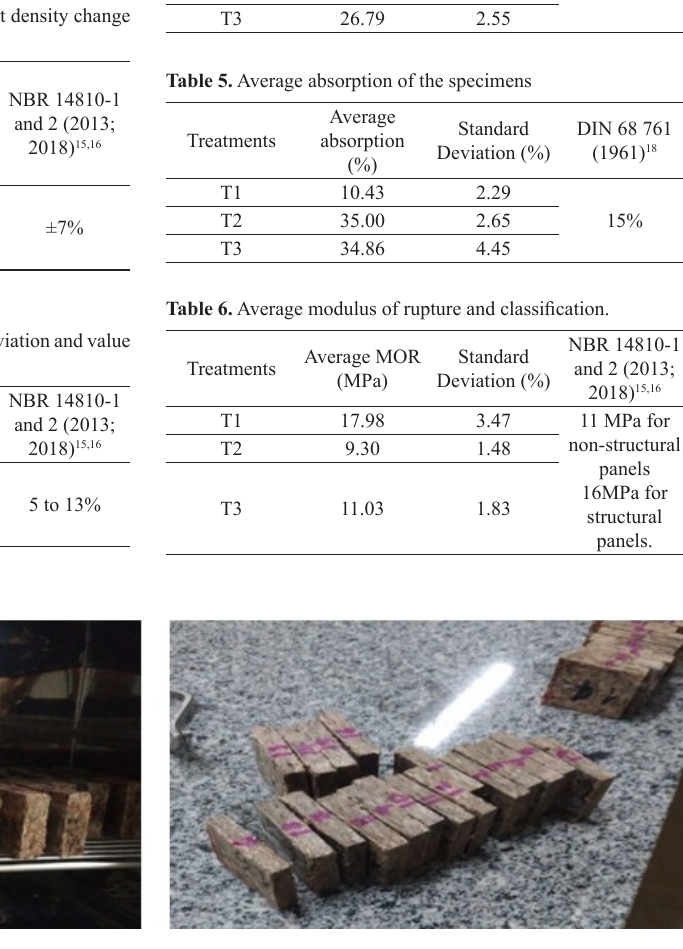
Figure 6. Aspects of specimens (a) Specimes at 100°C; (b) Specimes after 24 h at 100°C